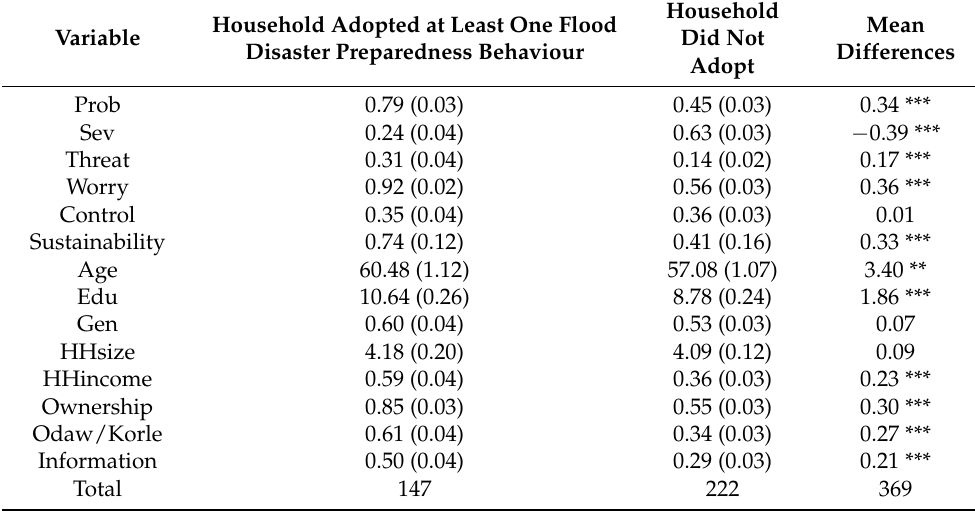
Table 4. Mean differences of selected variables according to household’s adoption of at least one flood disaster preparedness